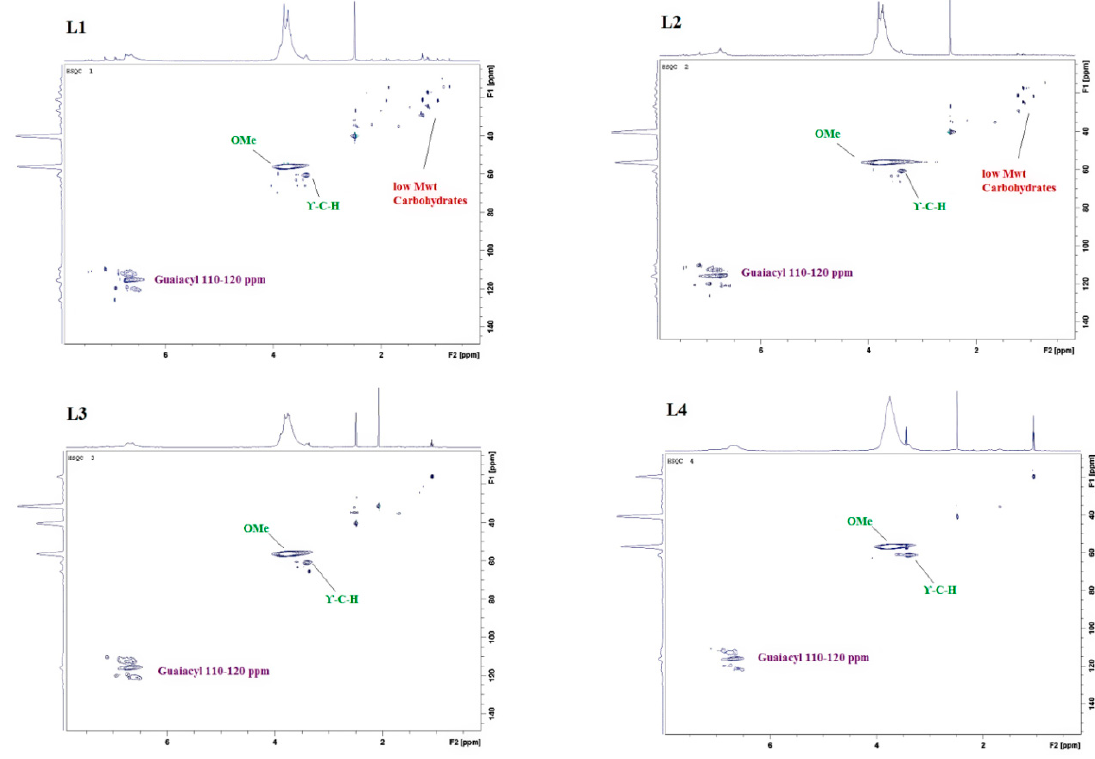
Figure 3. HSQC of lignin purification fractions: L1, L2, L3, and L4.